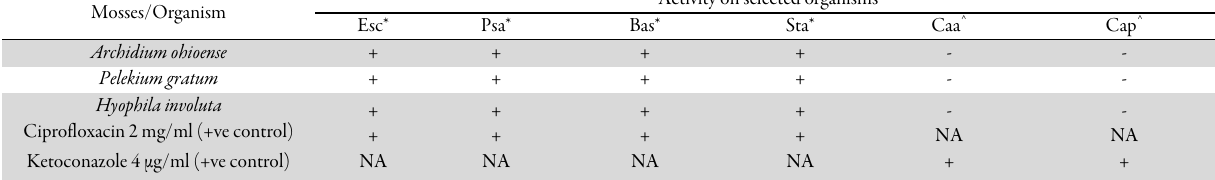
Table 4. Screening of antimicrobial activity of the Oil palm wine extracts of Archidium ohioense , Pelekium gratum , Hyophila involuta against different